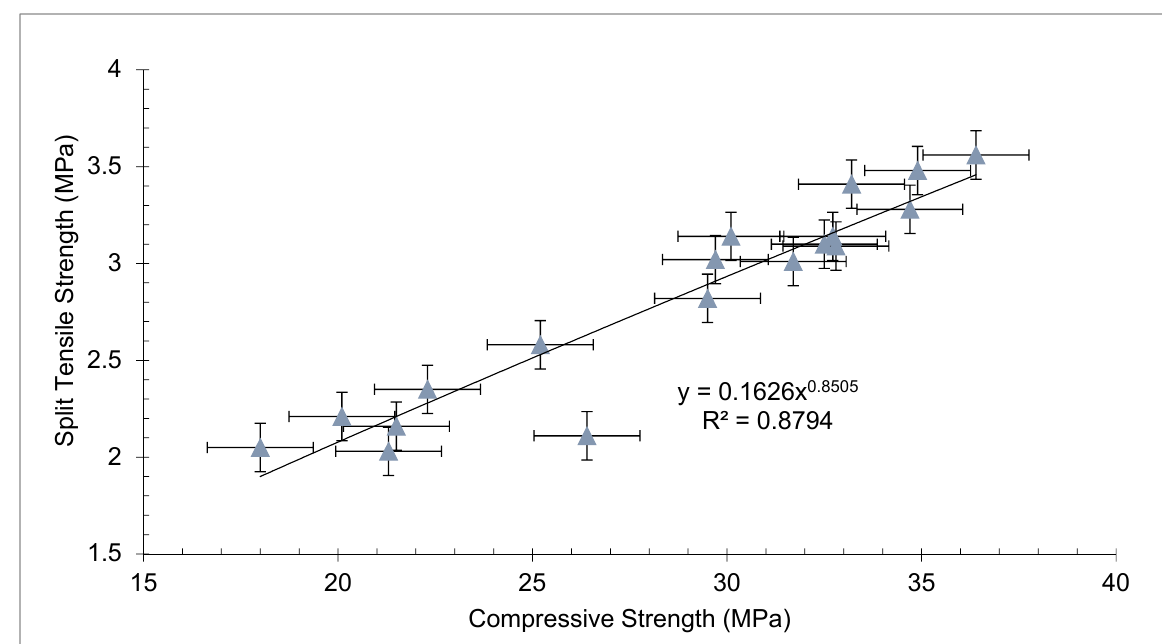
Table 3. Experimental and predicted tensile strength.